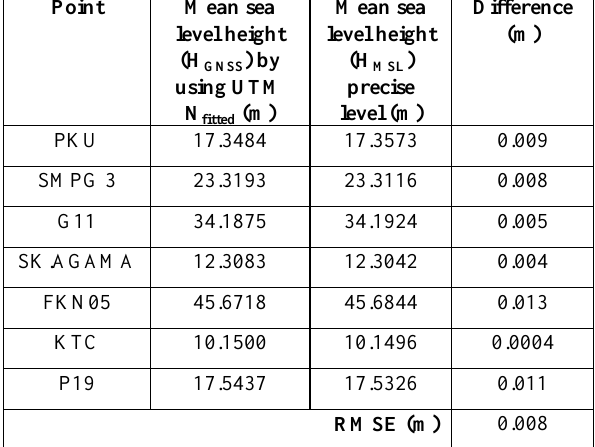
Table 11. RMSE value from the comparison of Mean Sea